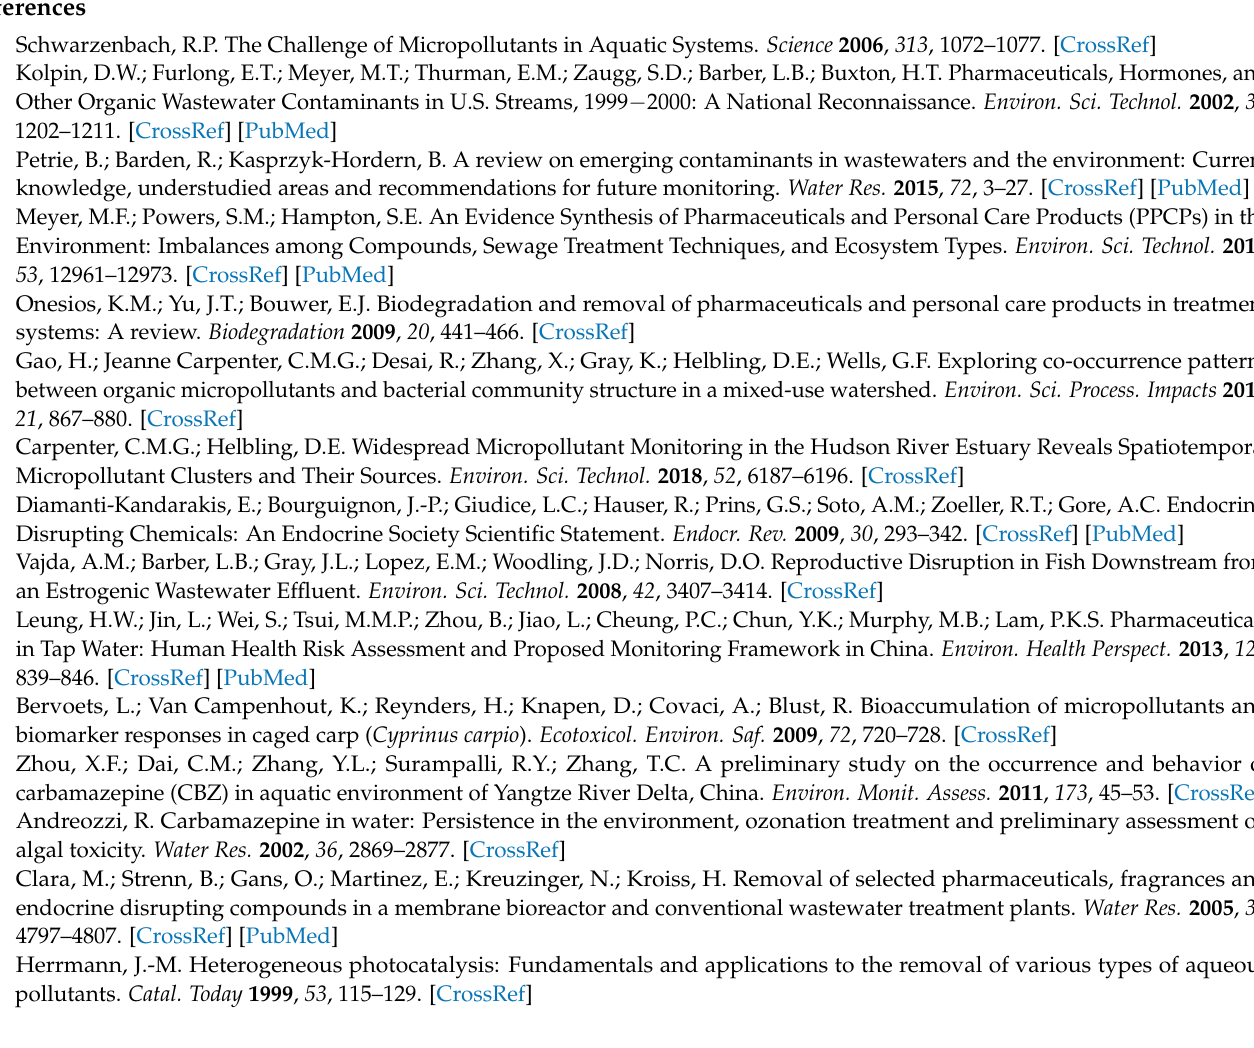
TiGC; Figure S9: CBZ photodegradation of TiGC at different pH; Figure S10: Langmuir adsorption model for carbamazepine adsorption with TiGC under different NOM